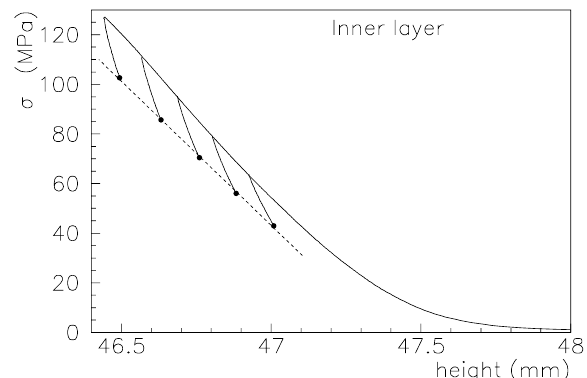
FIG. 11. Equivalent stress-displacement curve (dashed line) for the coil inner